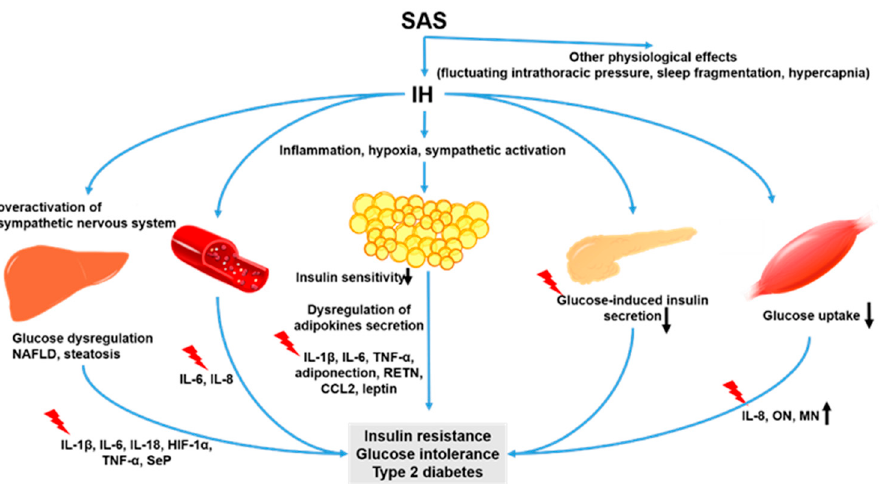
Figure 4. IH-induced dysfunctions in adipose tissues, skeletal muscle cells, and hepatocytes. Adipose tissues, skeletal muscle, and the liver are the main endocrine organs producing adipokines, myokines, and hepatokines, respectively. IH stimuli induce the expression/secretion of cytokines, which induce and/or worsen insulin resistance, glucose intolerance, and T2DM in adipocytes, skeletal muscle cells, and hepatocytes. IH also inhibits glucose-induced insulin secretion via the downregulation of CD38 [22] and vascular smooth muscle proliferation via IL-6-induced epiregulin expression [23,114]. IH promoted the production of TNF- α , IL-1 β , and IL-6 and caused inflammation and cell apoptosis in pancreatic tissue via the MAPK signaling pathway [109]. Black up and down arrows mean increment and decrease,